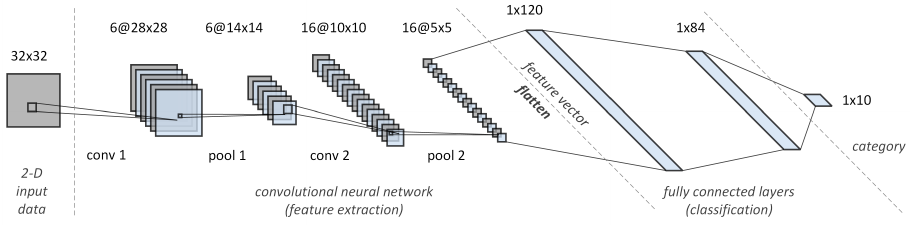
Figure 3. Architecture of the LeNet neural network